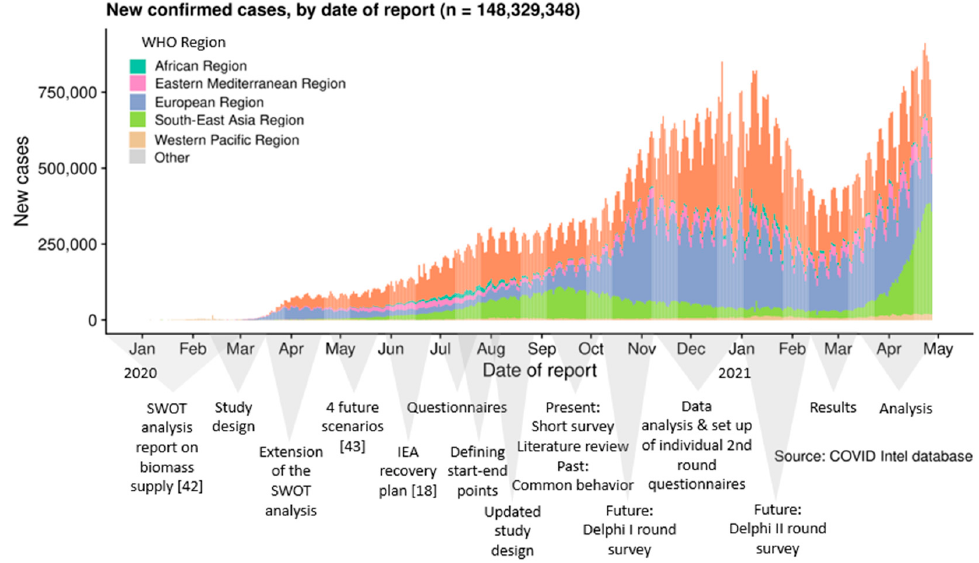
Figure 1. Timeframe of foresight research and pandemic developments (source [44], adjusted by authors).